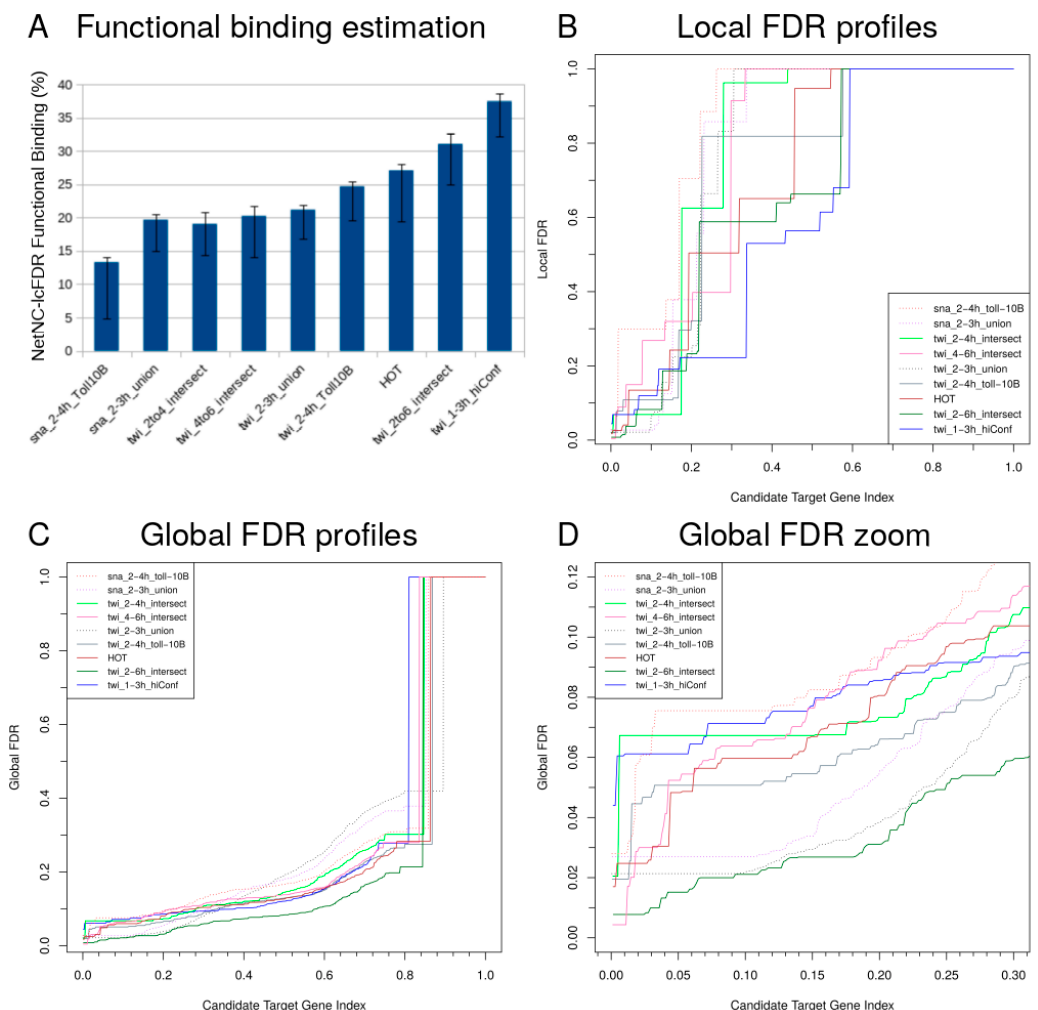
Figure 3. Functional transcription factor binding and false discovery rate (FDR) profiles. ( A ) Estimation of total functional binding. Median values are shown for NetNC-lcFDR, calibrated against resampled genes. Error bars represent 95% CI calculated using quantiles of results for the resampled datasets, which gave predicted functional binding ranging from 5% (sna_2–3h lower CI) to 39% (twi_1–3h_hiConf upper CI) across TF_ALL. Calibration based on synthetic data resulted in slightly higher functional binding estimates, up to 50% (Figure S2). ( B – D ) Line type and colour indicates dataset identity (see key). Candidate target gene index values were normalised from zero to one, in order to enable comparison across the TF_ALL datasets.